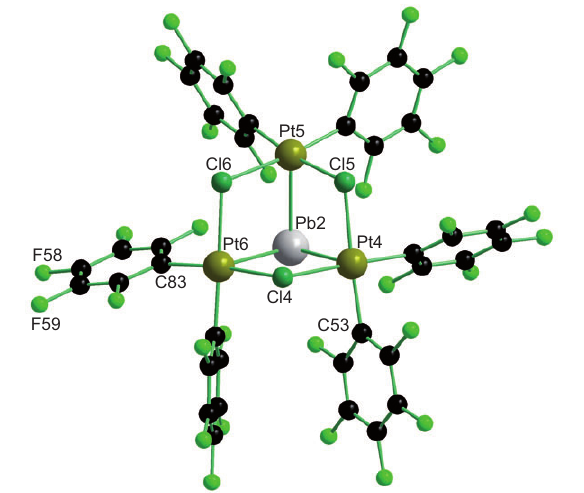
( μ -CO)Pt Tl(dk)(F CCO )] + . 3 3 3 3 2